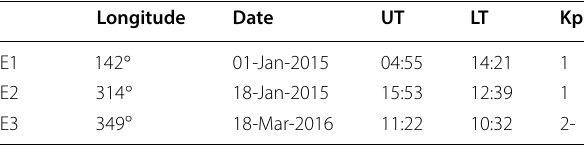
Table 3 Summary of the selected